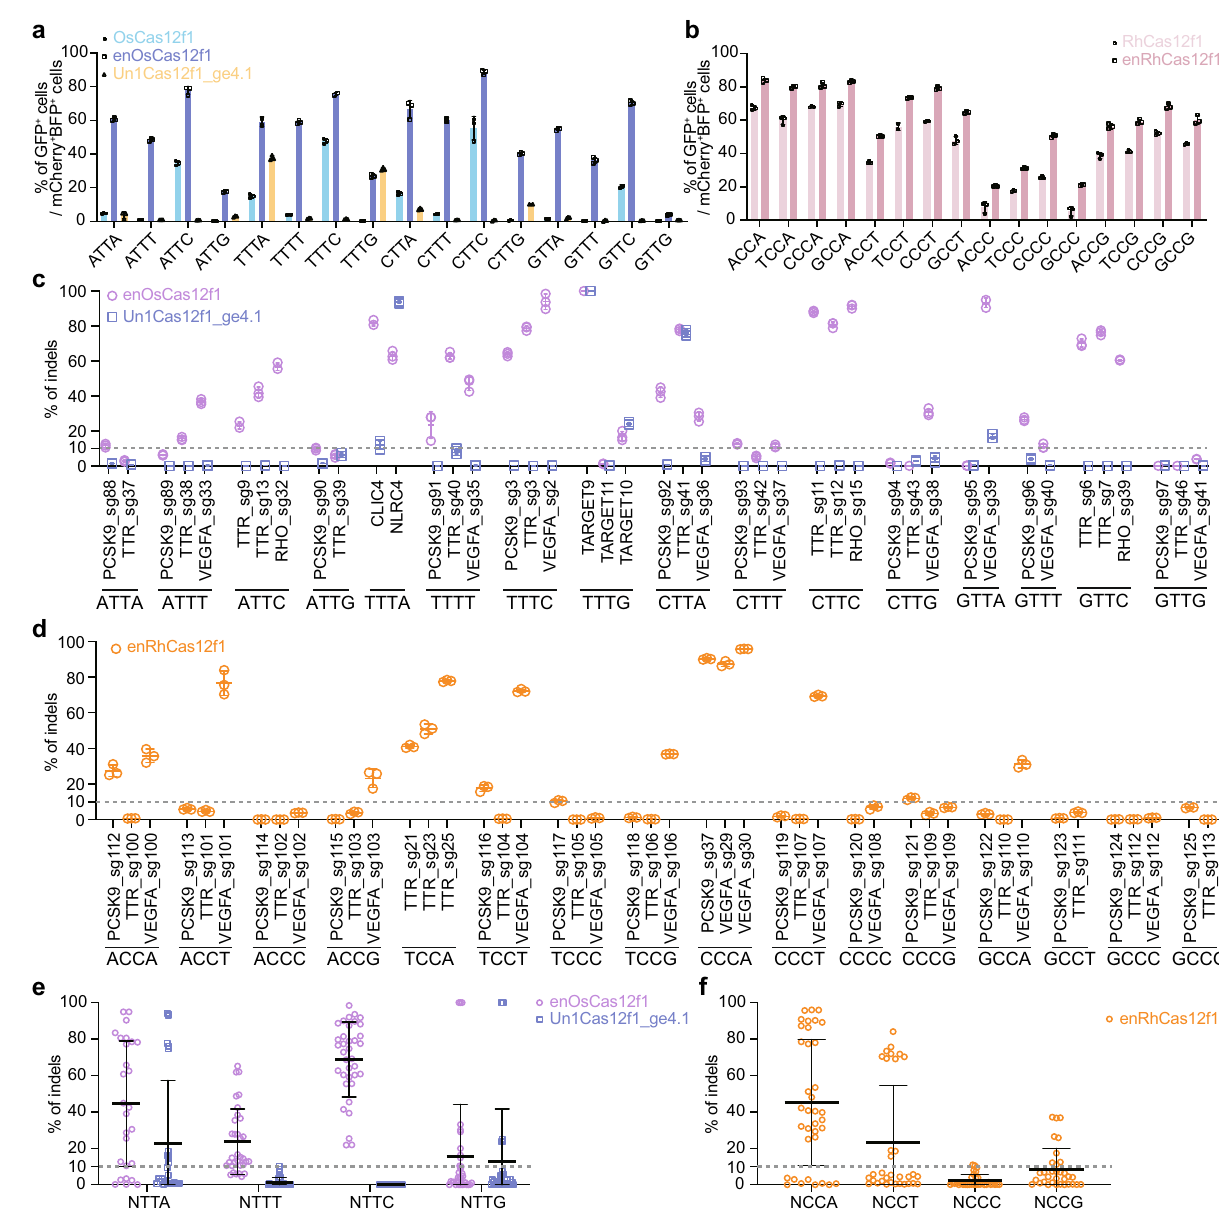
Fig. 3 | PAM preferencesofenOsCas12f1and enRhCas12f1. a PAM preferences of OsCas12f1, enOsCas12f1 and Un1Cas12f1_ge4.1 analyzed by GFP activation system. Target sequence: CCATTACAGTAGGAGCATAC. Values and error bars represent meanands.d.( n =3). b ComparisonofRhCas12f1-andenRhCas12f1-prefferedPAM. Target sequence: CCATTACAGTAGGAGCATAC. Values and error bars represent mean and s.d. ( n =3). c , d Validation the PAM preferences of enOsCas12f,